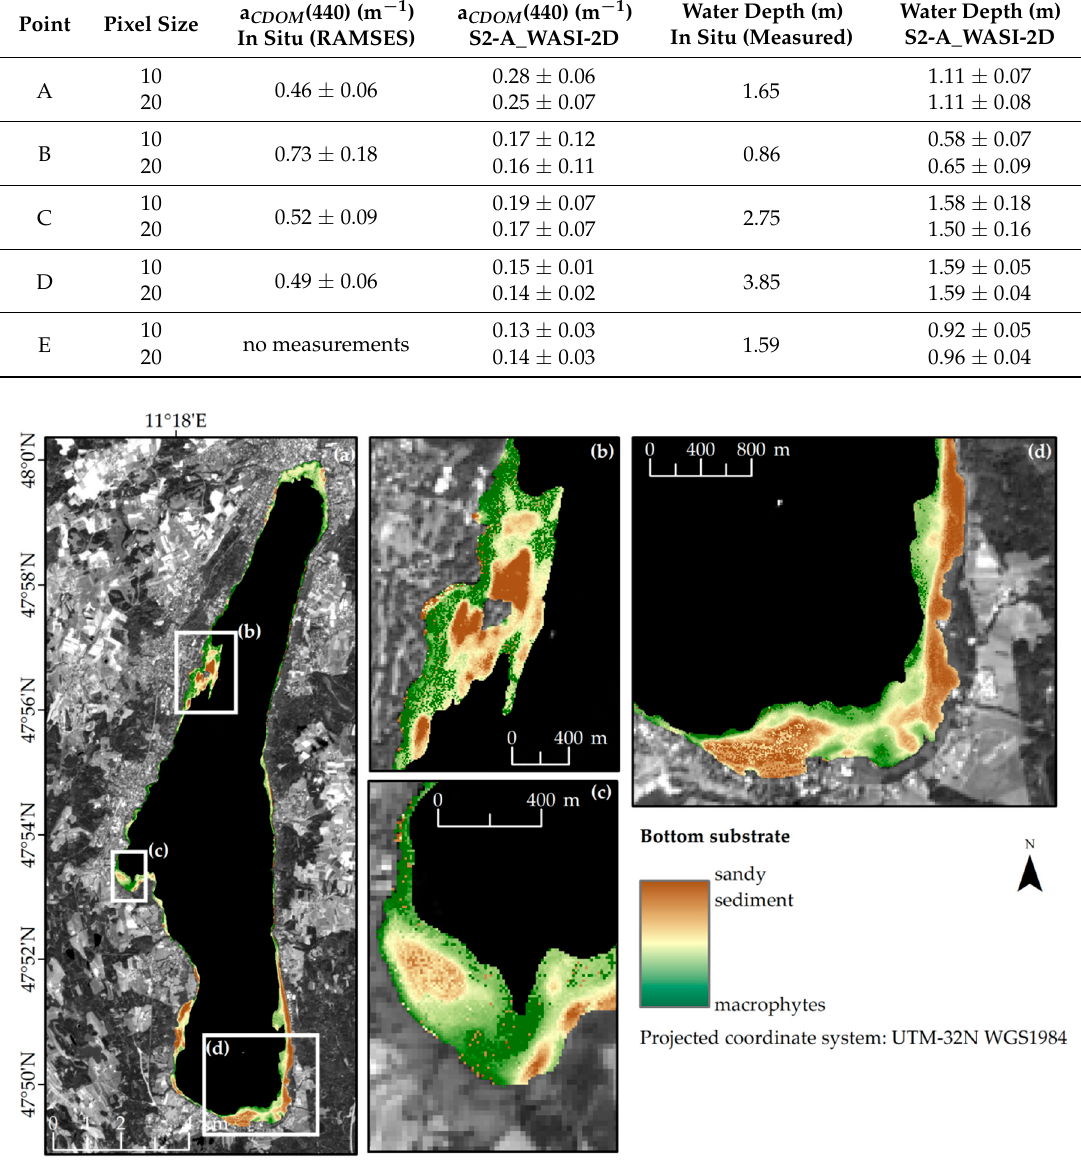
Figure 8. Results of bottom substrate unmixing using the MIP 10 m dataset ( a ); Zoomed areas are Roseninsel ( b ); Karpfenwinkel ( c ) and Seeshaupt ( d ). Low shares of sediment are illustrated as high macrophyte coverage. Background is gray scaled S2-A band B05 (705 nm).